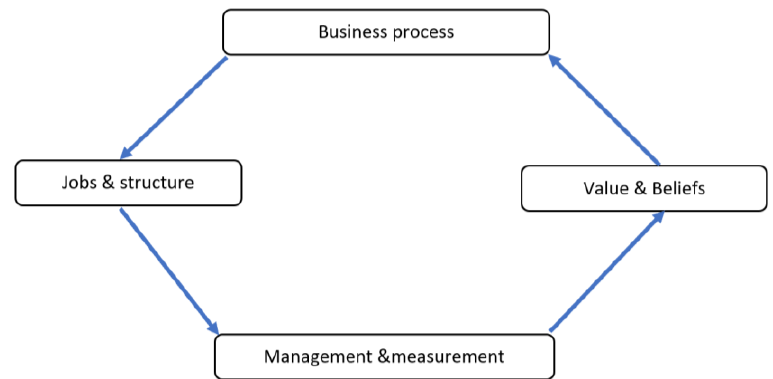
Figure 1. Hammer and Champy’s business system diamond.